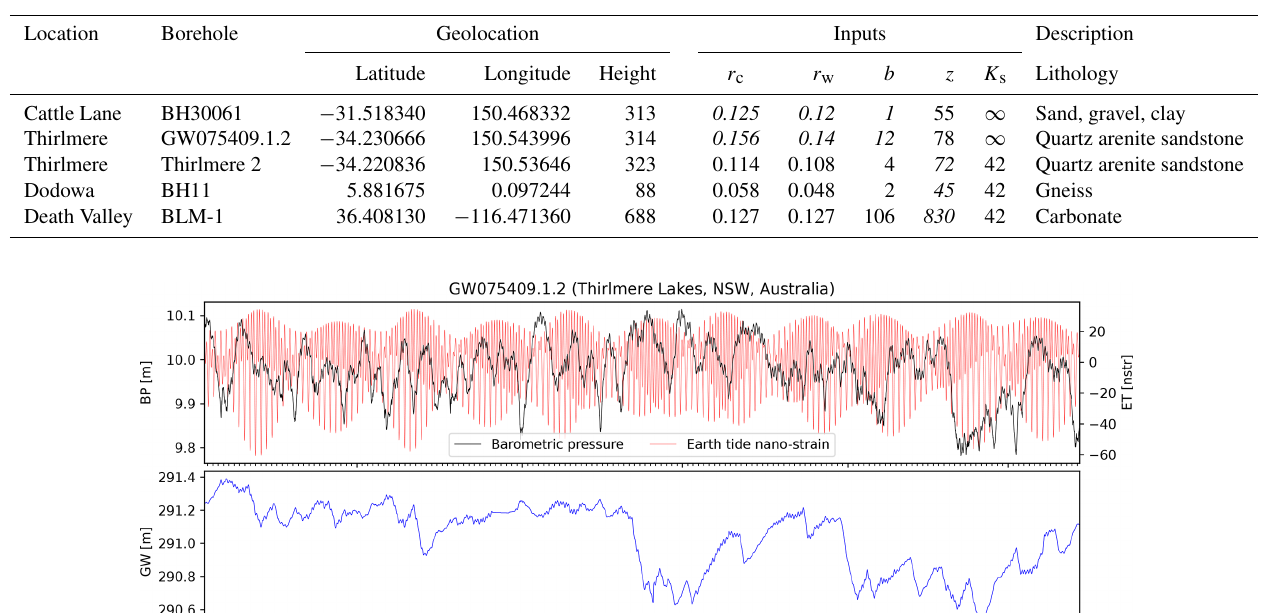
Table 2. Input parameters for case sites where r c is the outer diameter (m) of the bore casing, r w the internal diameter (m) of the bore casing, b is the Aquifer thickness (m) or open interval of the screen, z is the depth (m) to the centre of the screen or open bore interval, and K s is the assumed grain bulk modulus. Italicised values were not used in the applied leaky or confined models, but are provided for completeness and context.